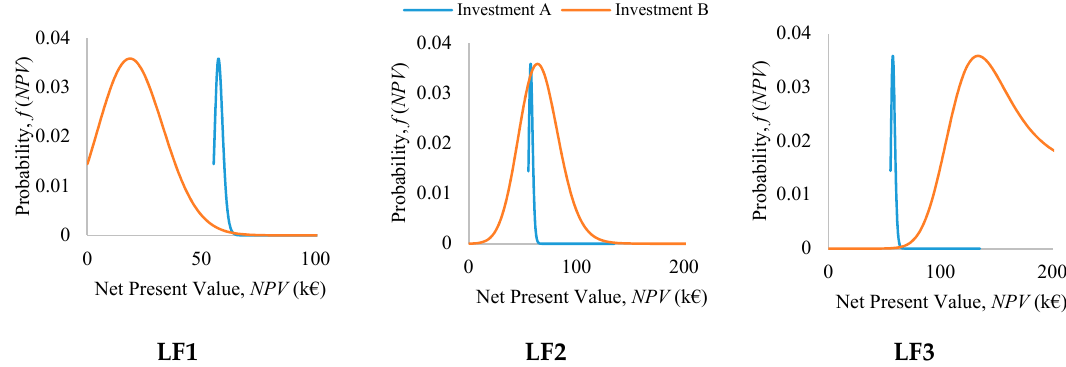
Figure 3. Probability distributions of the NPV of the two di ff erent investment options—“SEC reduction” (Investment A) and “SEC levelling” (Investment B)—under normal distributed demand and production rate.